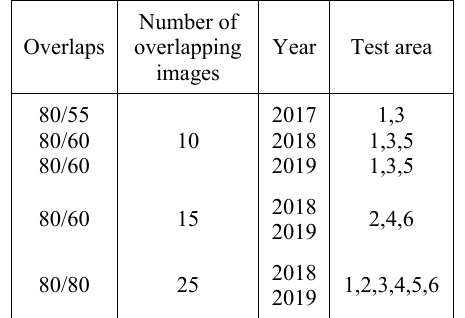
Table 2. The configurations of year of data acquisition and overlaps (and exact numbers of overlapping images) for particular test areas used during experiments.